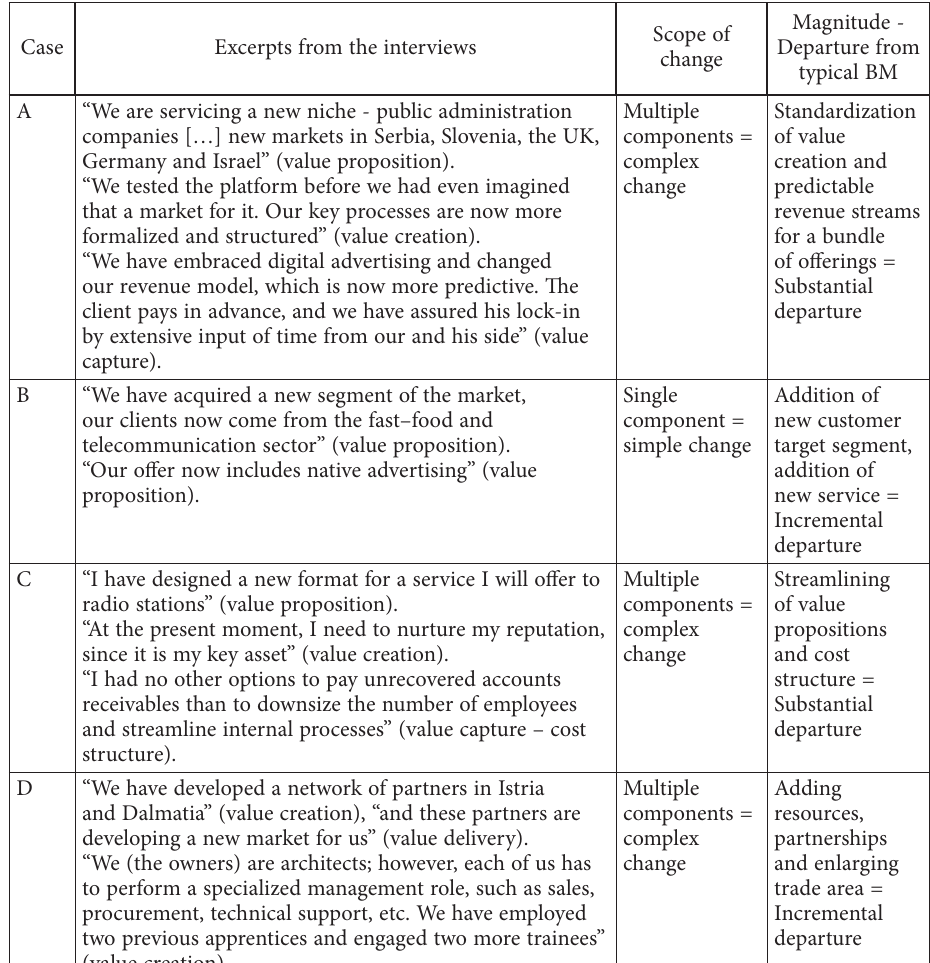
Table 4. Assessment of changes to business models (BMs) (source: created by